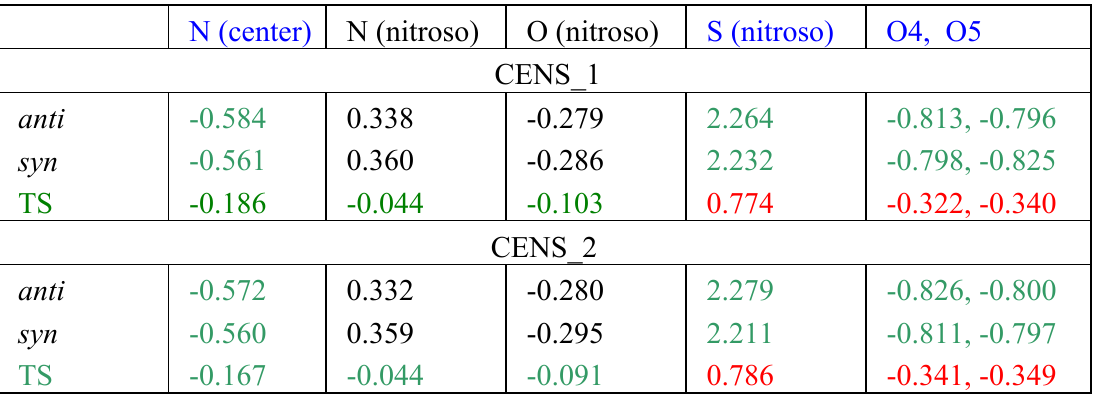
Table 8: The charge of selected atoms obtained by PM3 calculations (four CENS in syn , anti and transition